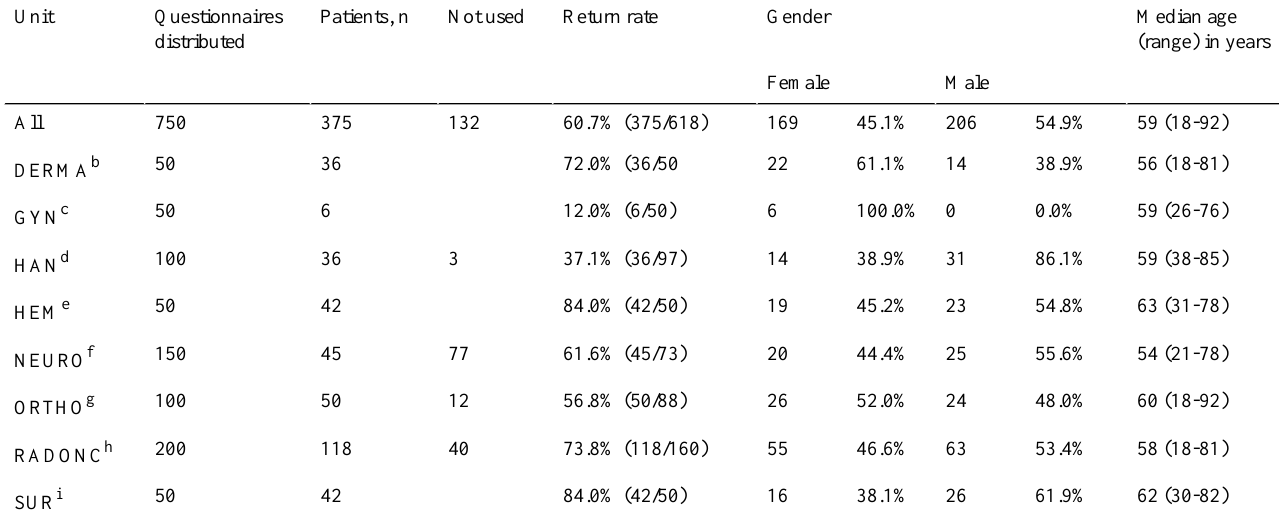
Table 1. Patient distribution according to the participating oncological